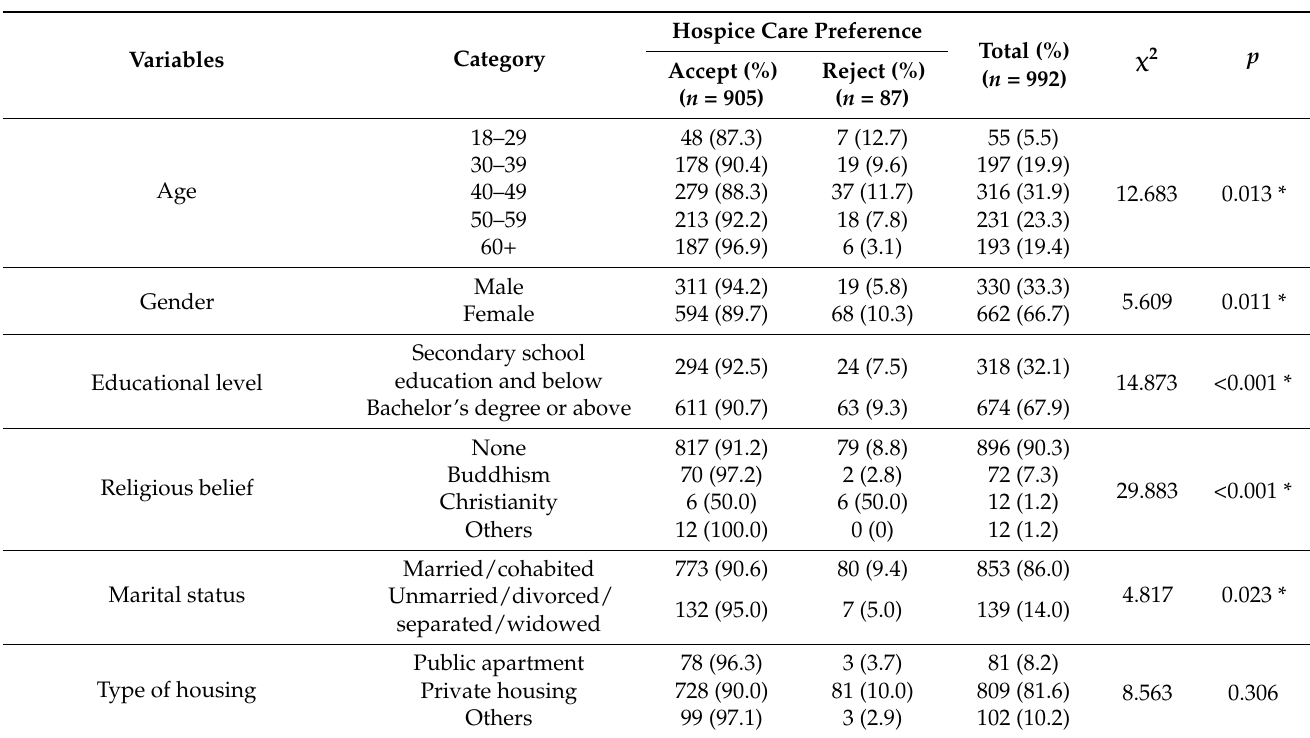
Table 3. Chi-square test identifying factors related to hospice care preference ( n =